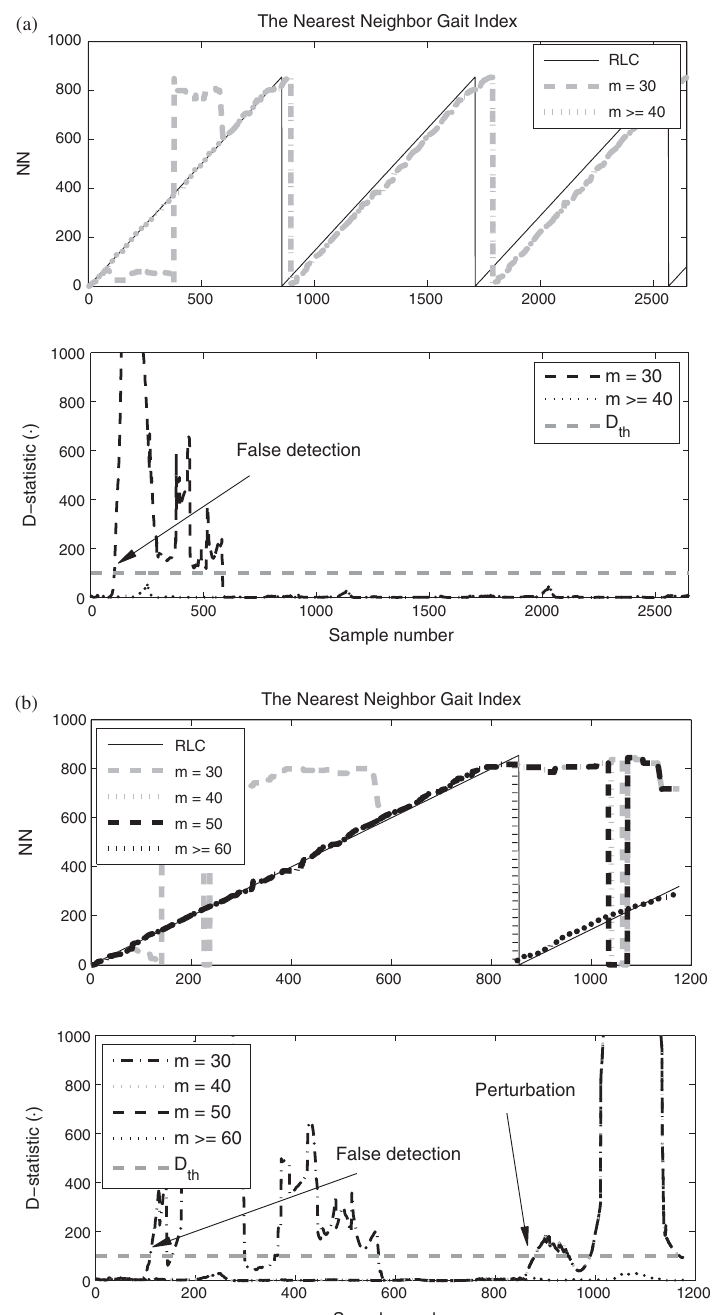
Fig. 5. Selection of the parameters of the algorithm: The length of the Ensemble of Candidate Neighbors, m (top), and the threshold for the D-statistic, D th (bottom). (a) Execution of the NNGI in one stable run of Meta. Top: The solid black line represents the RLC, the NNGI for different values of m is shown as dashed gray lines. Botton: Dashed and dotted black lines represent different values of m , the dashed gray line the D-statistic. (b) Execution of the NNGI during trip trial 1 (which ended in a fall). Top: The solid black line represents the RLC, the NNGI for different values of m is shown as dashed gray and black lines. Bottom: The four black lines represent different values of m , the dashed gray line the